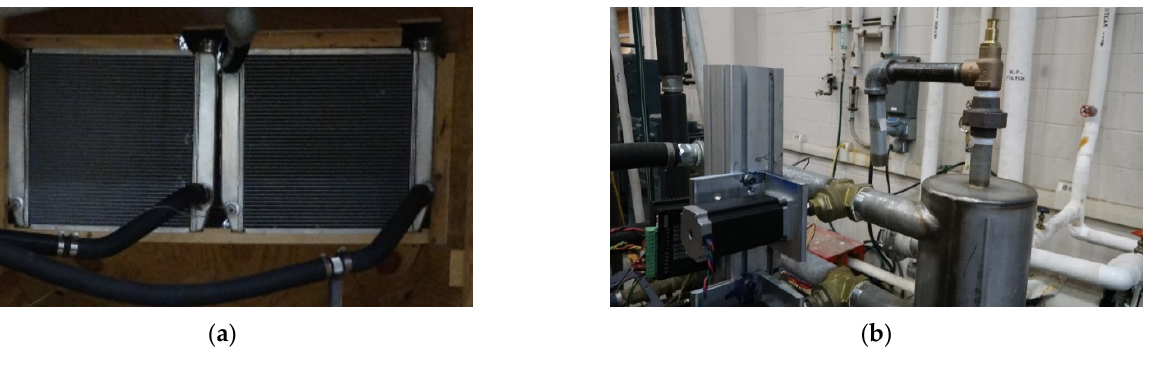
Figure 3. Experimental system at Clemson University testing facilities: ( a ) Twin radiators in parallel, ( b ) Swirl pot with servo motor-controlled outlet valves.